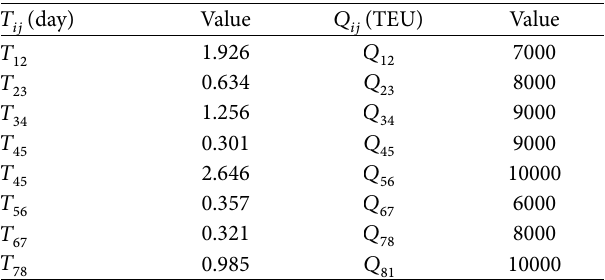
Figure 3: Sensitivity analysis at different benchmark speeds Table 4: Agreed delivery schedule and cargoes onboard.